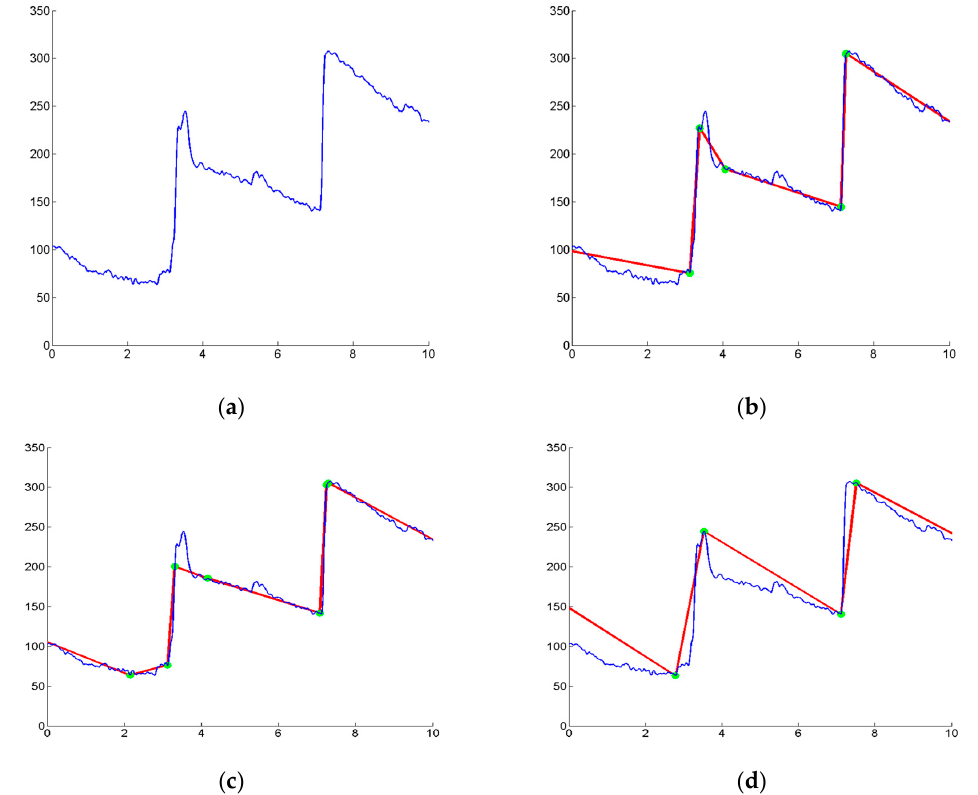
Figure 9. PLA results for EOG signal with overshooting phenomenon. ( a ) EOG signal with overshooting; ( b ) PLA using RMSE ( c ) PLA using Euclidean Error; ( d ) PLA using Euclidean Distance.